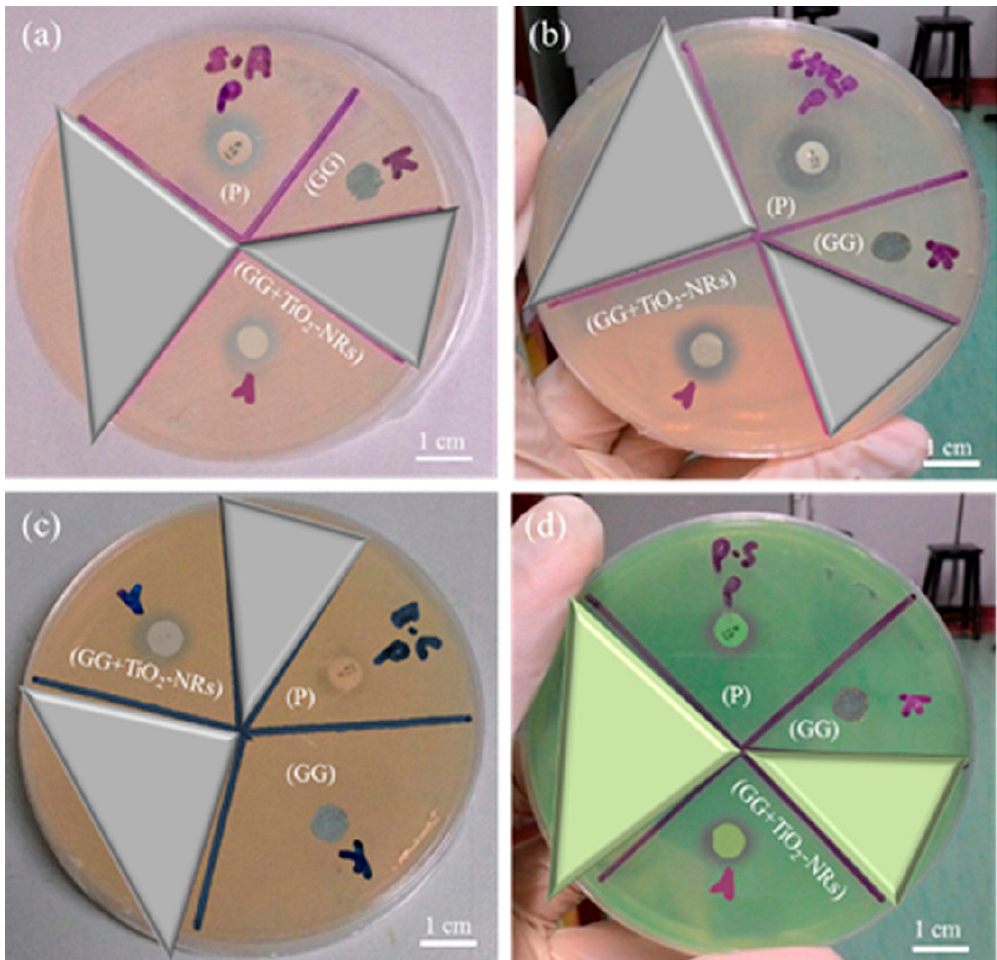
Fig. 6. Antimicrobial activity of GG and GG+TiO2-NRs films against (a) Staphylococcus aureus , (b) Streptococcus , (c) Escherichia coli , and (d) Pseudomonas aeruginosa